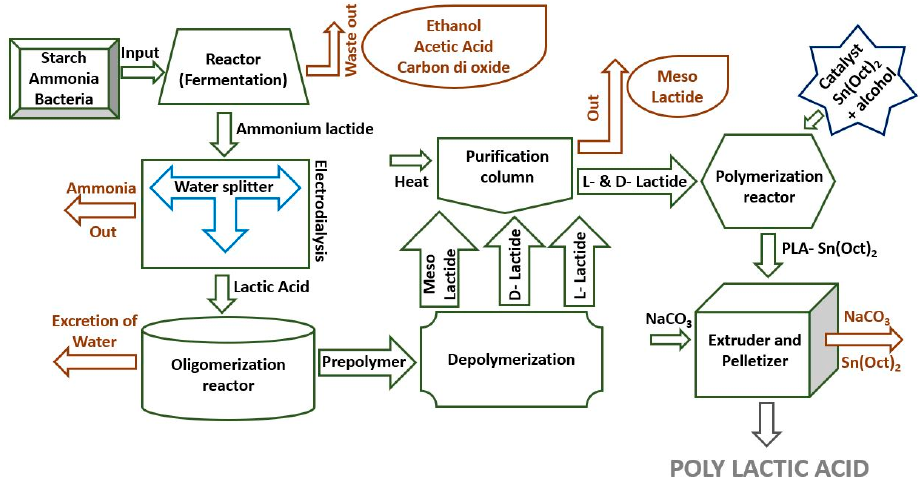
Figure 3. Process of making polylactic